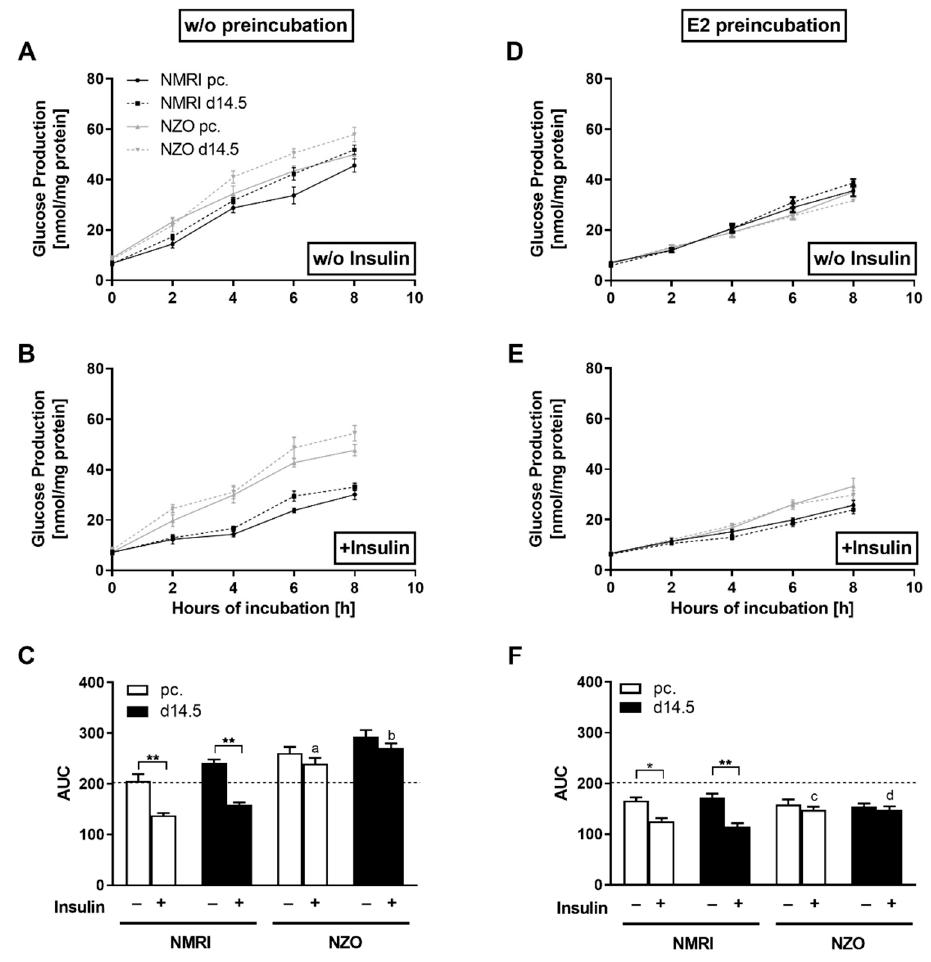
Figure 3. Altered glucose utilization in primary NZO hepatocytes and the effect of E2. Glucose production in cultured primary hepatocytes of NMRI and NZO mice at time points preconceptional and d14.5. ( A , B ) Preincubation without ( w / o ) ( D , E ) or with E2 and ( A , D ) stimulation w / o or ( B , E ) with insulin. Area under the curve (AUC) for glucose production using the trapezoidal rule at time points preconceptional (white bars) and d14.5 (black bars). ( C ) w / o and ( F ) after preincubation with E2. Data are presented as means ± SEM (n = 5 animals per group). * p < 0.05, ** p < 0.01, NMRI pc. w / o vs. NZO pc. w / o : a p < 0.05, NMRI d14.5 w / o vs. NZO d14.5 w / o : b p < 0.05, NMRI pc. + E2 vs. NZO pc. + E2: c p < 0.05, NMRI d14.5 + E2 vs. NZO d14.5 + E2: d p < 0.05.